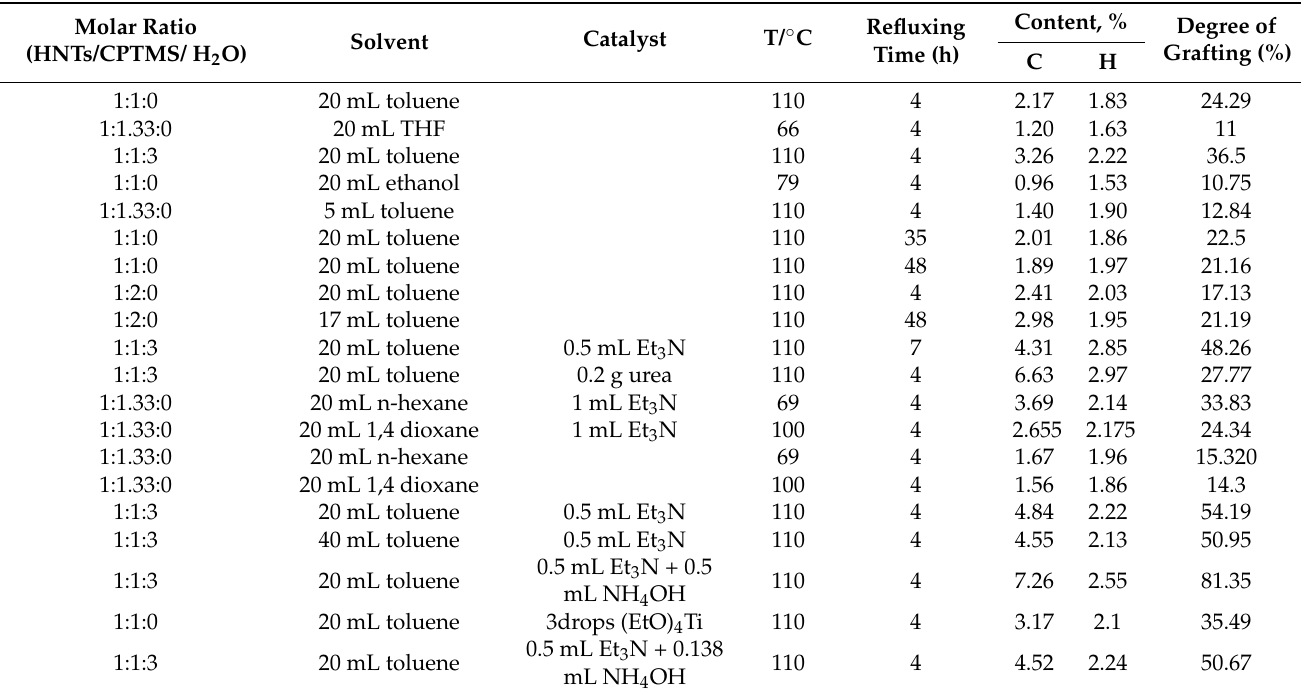
Table 1. The different parameters which were used for the grafting process and the results obtained from elemental analysis. Molar